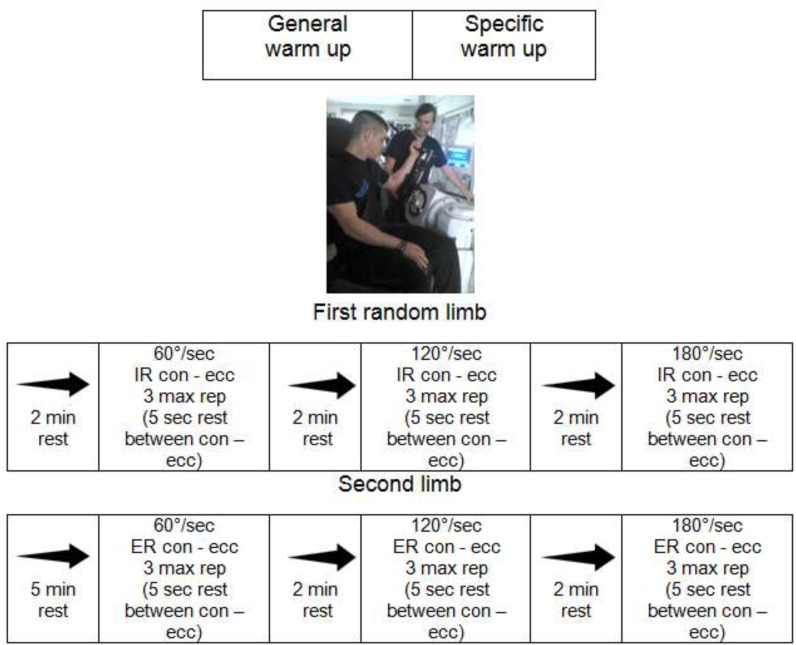
Experimental set-up. max, maximum; rep, repetitions; IR, internal rotator; ER, external rotator; 60, 120, and 180°/s, angular velocity; con, concentric; ecc, eccentric.